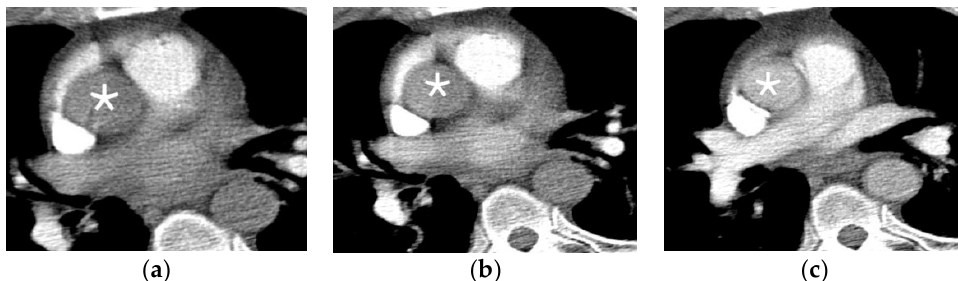
Figure 1. Consecutive axial images acquired during bolus tracking. The region of interest was placed over the ascending aorta, as marked by an asterisk. ( a ) Ascending aorta with attenuation greater than 50 Hounsfield units; ( b ) Ascending aorta with attenuation greater than 50 and less than 100 Hounsfield units; ( c ) Ascending aorta with attenuation greater than 120 Hounsfield units, at which point image acquisition began.